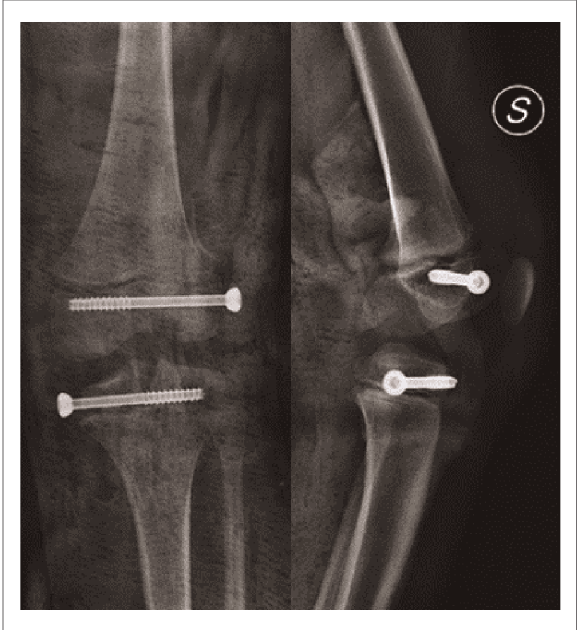
FIGURE 2 Postoperative x-ray control after reduction and synthesis of left knee growth plate